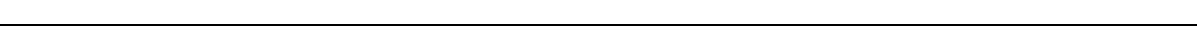
Fig. 3 The top clinically relevant S-phase lncRNAs regulate crucial cancer cell hallmarks. a Kaplan – Meier plots of SCAT1 ̶ SCAT8 indicating overall survival of patients in KIRC. The higher expression of all SCATs is correlated with poor overall survival. The expression cut-off and the signi fi cance value for each SCAT are indicated in the plots. UQ represents upper quartile of the patients ’ expression levels. The Forest plots represent the multivariate models derived for each SCAT in combination with the signi fi cant clinical parameters. The hazard ratio (HR) using Cox proportional hazard analysis and the associated p - values were calculated using Wald statistics. b Proliferation capacity of HeLa cells as measured by MTT colorimetric assay 48 h post-silencing of SCATs using two different LNAs ( SCAT1 , SCAT2 , SCAT4 , SCAT5 , and SCAT6 ) or siRNAs ( SCAT3 and SCAT7 ). Data are represented as percentage compared to cells transfected with respect to the negative control. No signi fi cant difference was observed between LNA-negative control and siRNA-negative control. c Cell cycle pro fi les of HeLa cells depleted with two different LNAs or siRNAs targeting the seven SCATs. d Estimation of the caspase 3/7 activities 48 h post-silencing of SCATs in HeLa cells. Data are expressed as fold change with respect to the corresponding negative controls. e MTT proliferation assay of Caki-2 (KIRC) cell line depleted with two independent LNAs ( SCAT4 , SCAT8 ) or siRNAs ( SCAT7 ). f Cell cycle pro fi les of Caki-2 cells depleted with two different LNAs or siRNAs. g Estimation of the caspase 3/7 activities 48 h post-silencing of the corresponding SCAT in Caki-2 cells. Data in b – g are shown as mean ± SEM of three independent experiments. Signi fi cance levels were derived using unpaired two-tailed Students ’ t -test. (* p ≤ 0.05; ** p = 0.01 ̶ 0.001; *** p <